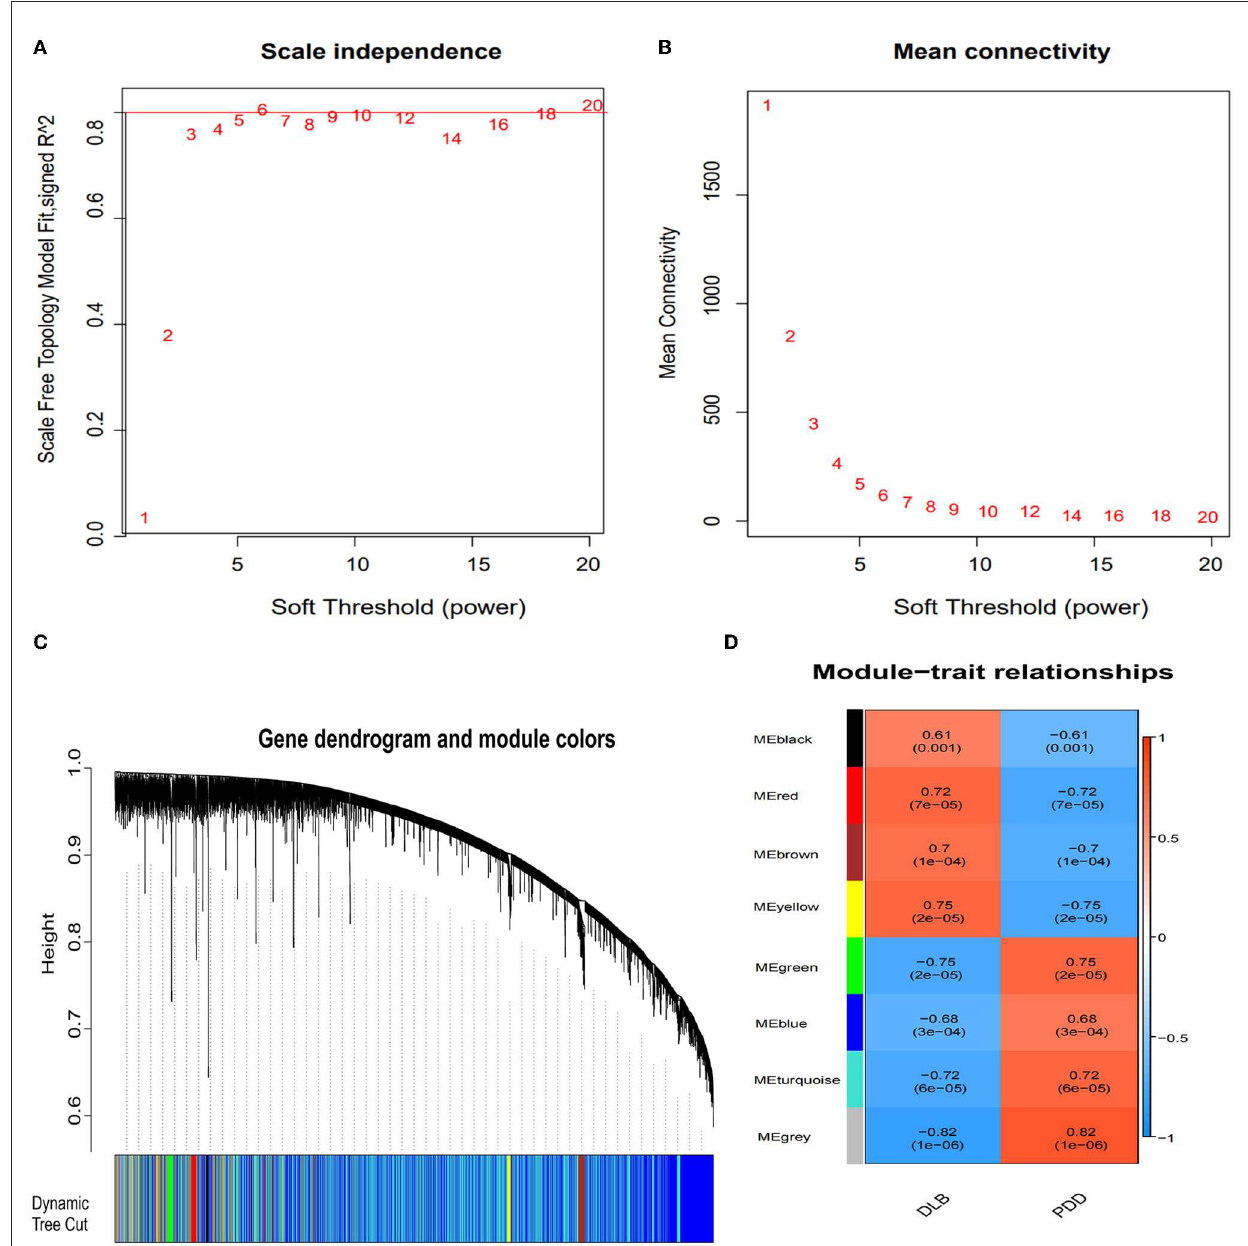
FIGURE4 Identification of the gene modules related to Parkinson’s disease dementia (PDD) and Dementia with Lewy bodies (DLB) by weighted gene co-expression network analysis (WGCNA). (A) Determination of the soft threshold in the WGCNA algorithm. The approximate scale-free fit index can be attained at the soft-thresholding power of 6. (B) Mean connectivity of various soft-thresholding powers. (C) Clustering dendrograms showing eight modules that contain a group of highly connected genes. Each designated color represents a certain gene module. Diverse colors reflect corresponding modules, and the gray module represents genes that are not assigned to each network. (D) The heatmap of the relationship between each gene module and each subtype of LBD. The red color represents a positive correlation, while the blue color represents a negative correlation. Each cell contains the corresponding correlation and P-